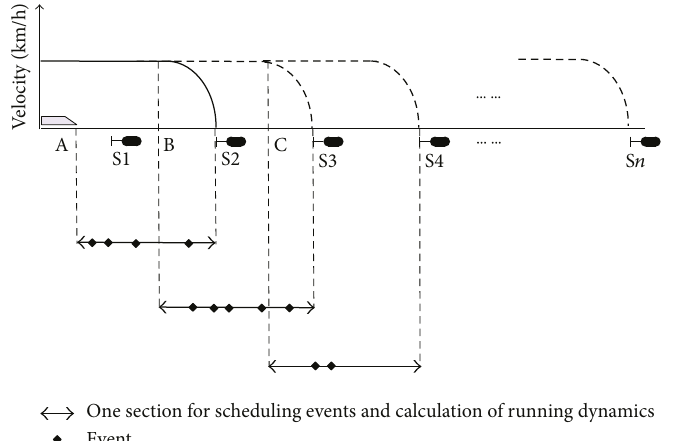
Figure 1: An example of event scheduling and calculation of running